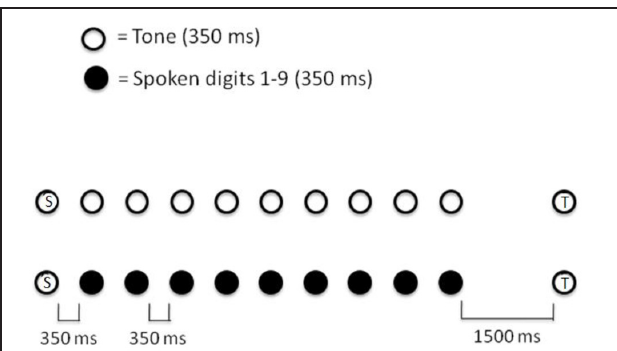
FIGURE 3 | Schematic depiction of the task from Deutsch (1970) and Jones et al. (1997a). The standard tone (S) is succeeded either by a series of other tones of varying frequency or by a random sequence of spoken digits, followed in turn by the test tone (T) either identical in pitch to the standard, or a semitone higher or lower.